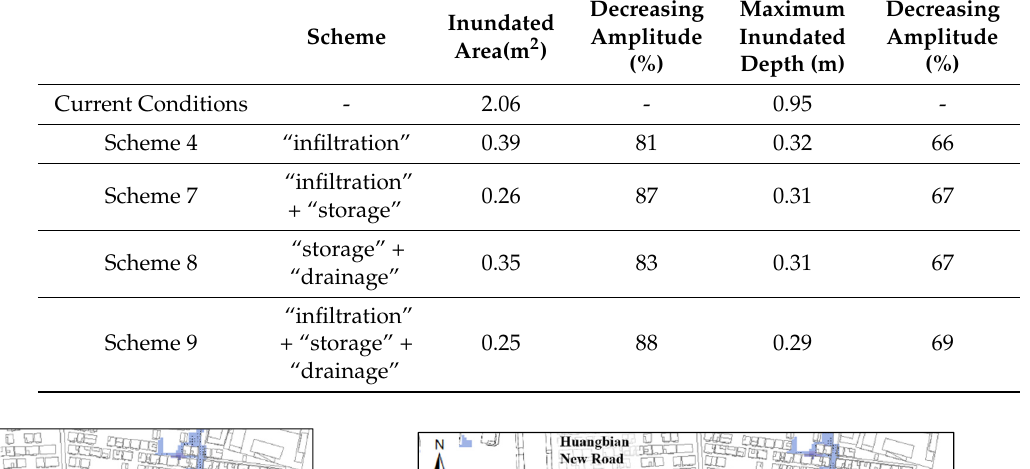
Table 3. Simulation statistics of different schemes against waterlogging under designed rainfall conditions.